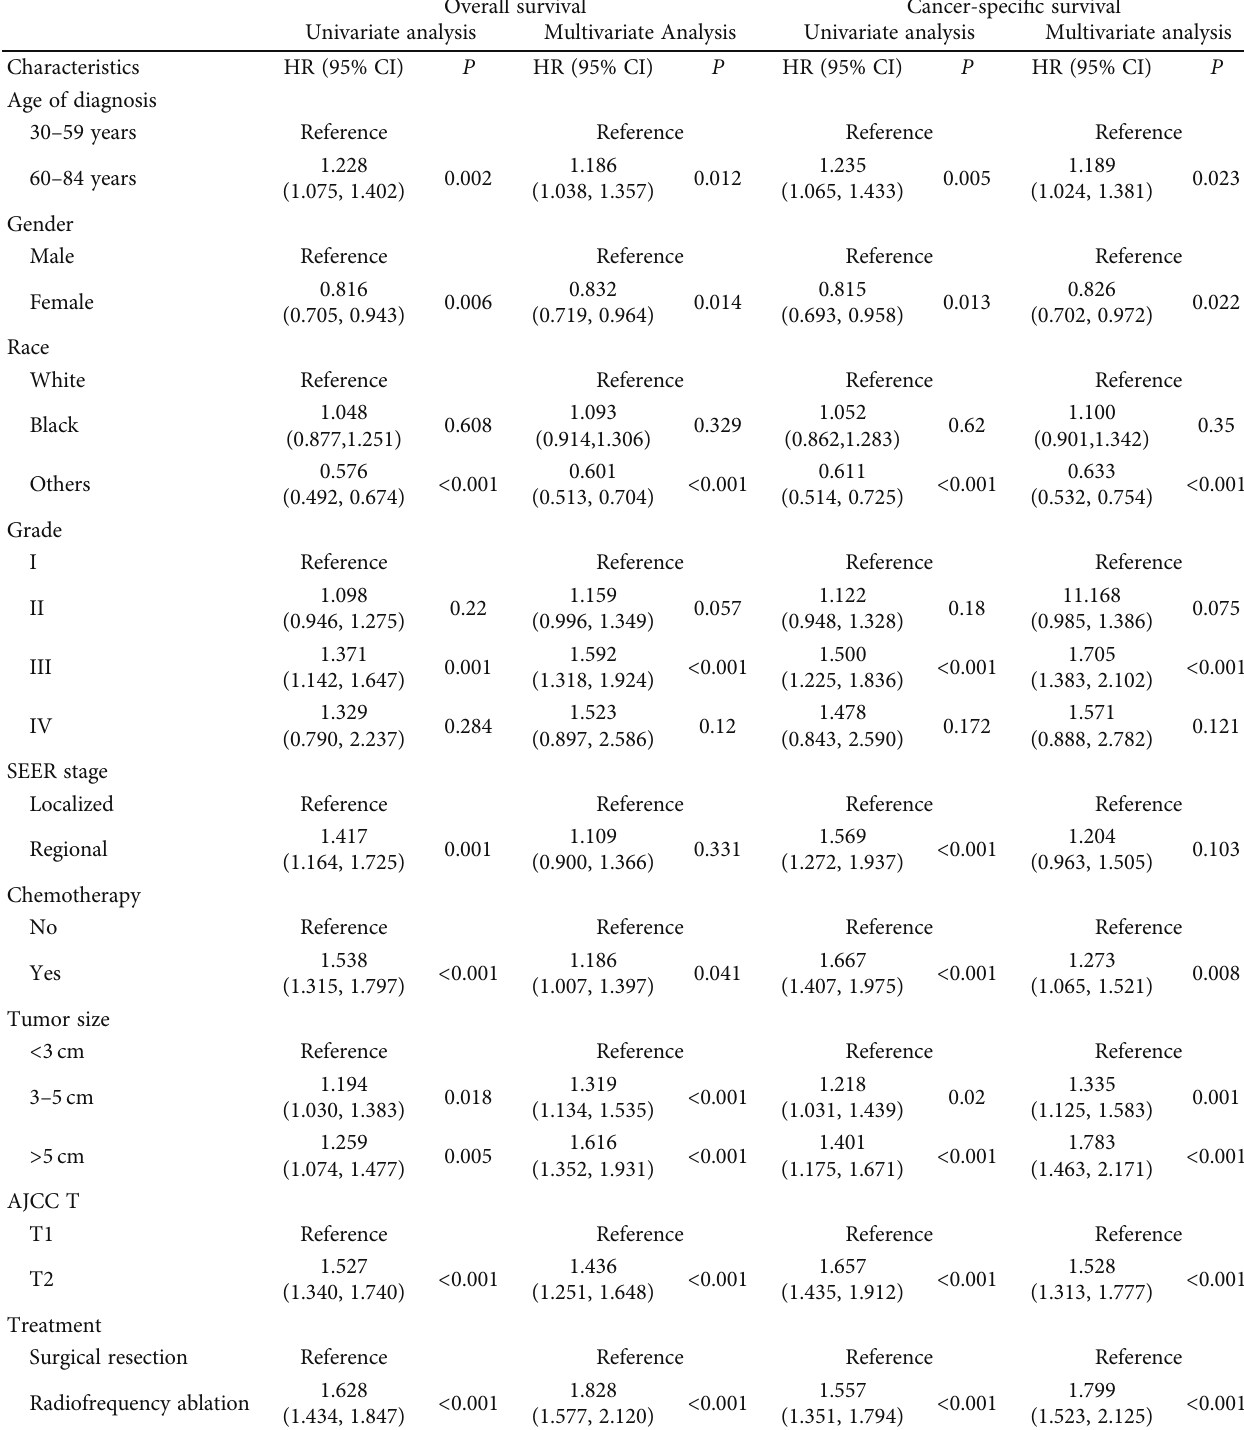
Table 2: Predictors for overall survival and cancer-speci fi c survival prior to